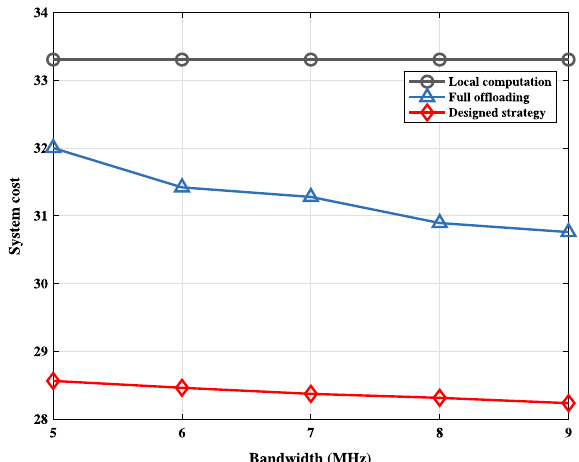
Fig. 6 System cost comparison of three schemes under the different values of bandwidth